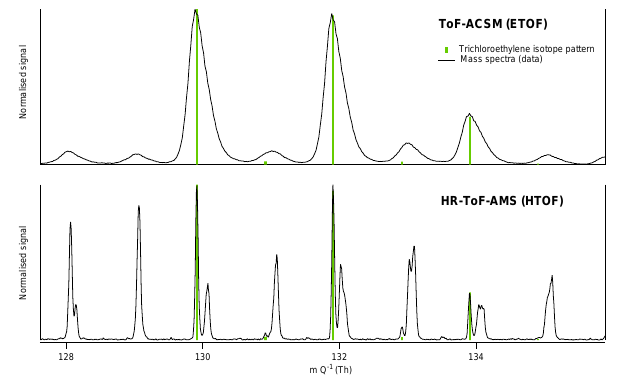
Figure 5. Mass spectra from the ToF-ACSM and HR-ToF-AMS showing the isotope pattern of trichloroethylene (C 2 Cl 3 H + )